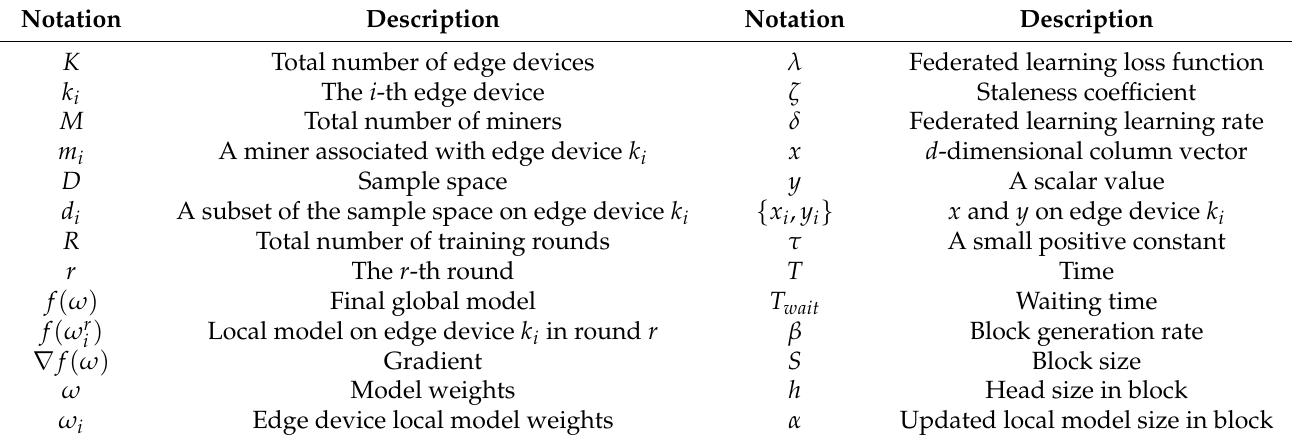
Table 1. List of